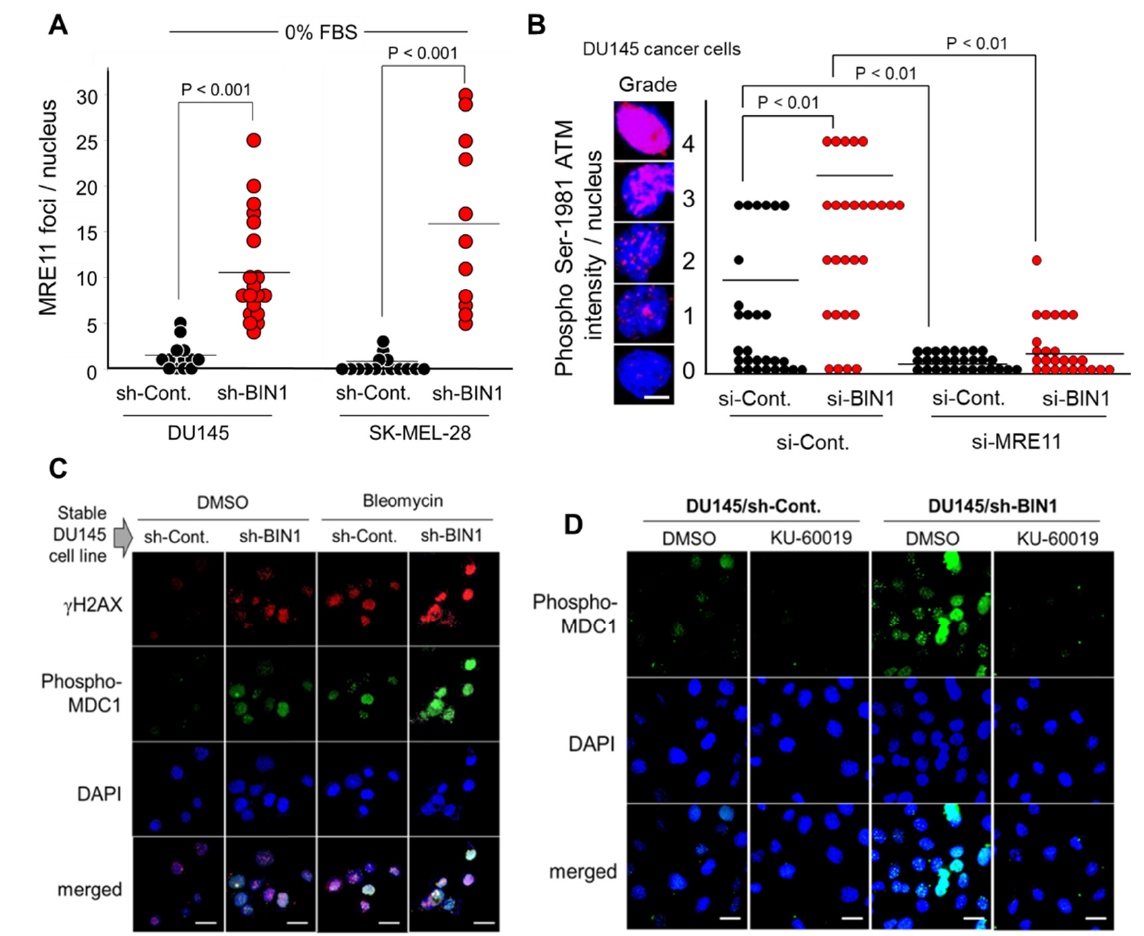
Figure 2. The forced BIN1 depletion increases DDR-like signals in the absence of DSBs. In situ immunofluorescence microscopy analysis demonstrated that the reduction in endogenous BIN1 by stable expression of sh-BIN1 increases ( A ) the formation of MRE11A foci even in the absence of serum; ( B ) the Ser1981-phosphorylated ATM nuclear intensity in an MRE11-dependent manner; ( C ) γ H2AX foci (red) and phosphorylated MDC1 (green); and ( D ) ATM-dependent MDC1 foci (green). Bleomycin, a radiomimetic chemical, was used at 20 µ g/mL for 30 min as the trigger of real DSBs [21]. KU-60019 (an ATM-selective small molecule inhibitor) was used at 3.0 µ M for 72 h [21]. DMSO (dimethyl sulfoxide) was used as the vehicle control. Nuclei were counter-stained with DAPI (4 (cid:48) , 6-diamidino-2-phenylindole) (blue). Scale bar, 10 µ